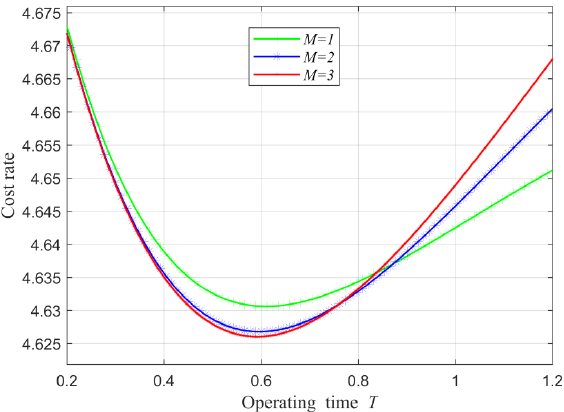
Figure 4. The test of the optimal CRR.